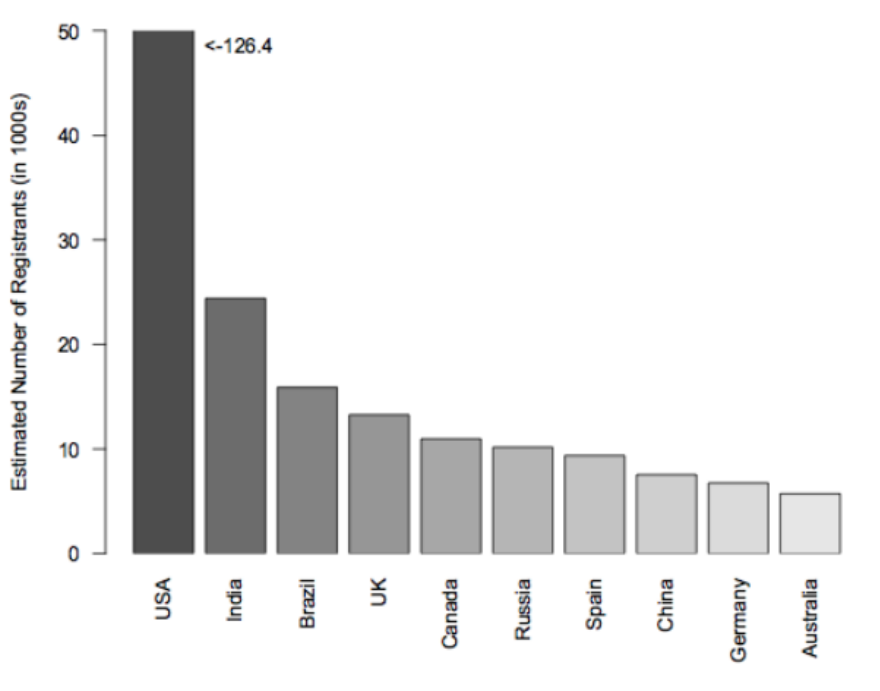
Figure 3. National Affiliation of Users (Using IP-Adress) (Perna et al., 2013, slide